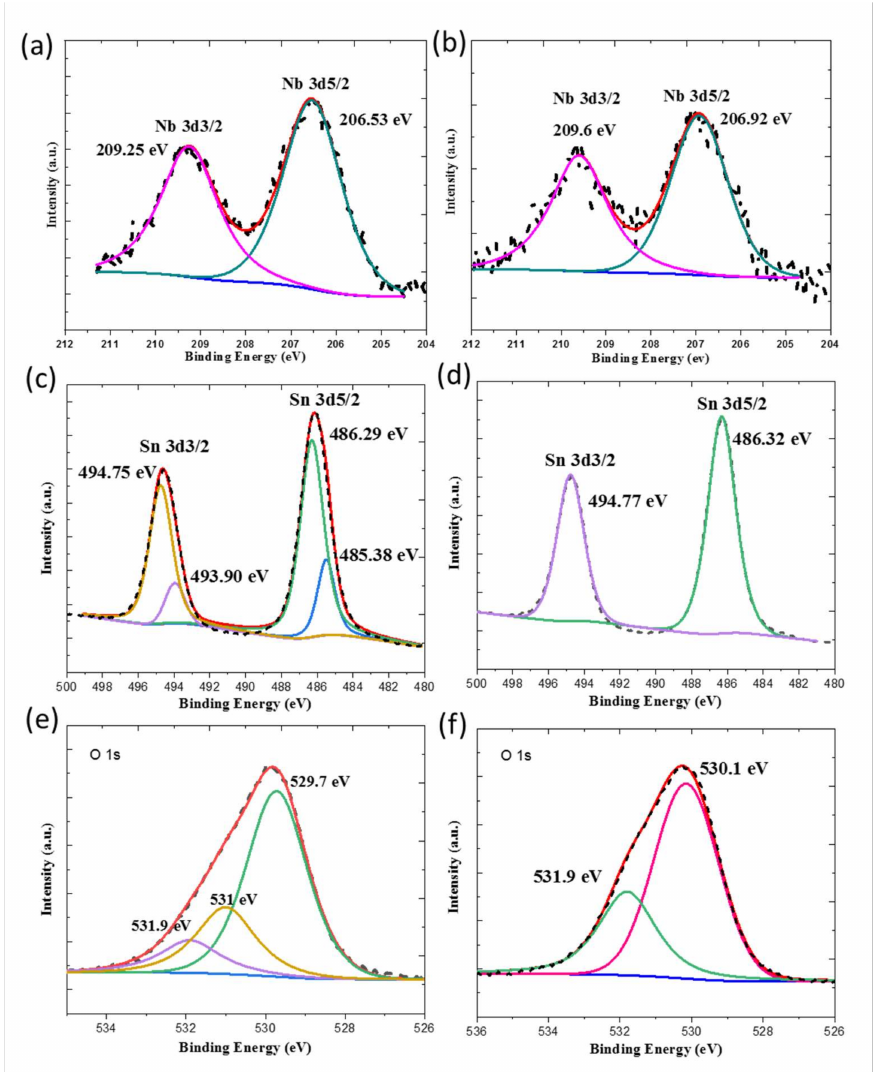
Figure 4. Deconvoluted XPS spectra of Nb 3d, Sn 3d, and O 1s of the as-deposited ( a , c , e ) and the annealed ( b , d , f ) Nb:SnO 2 thin films deposited at 4.0 sccm of oxygen flow